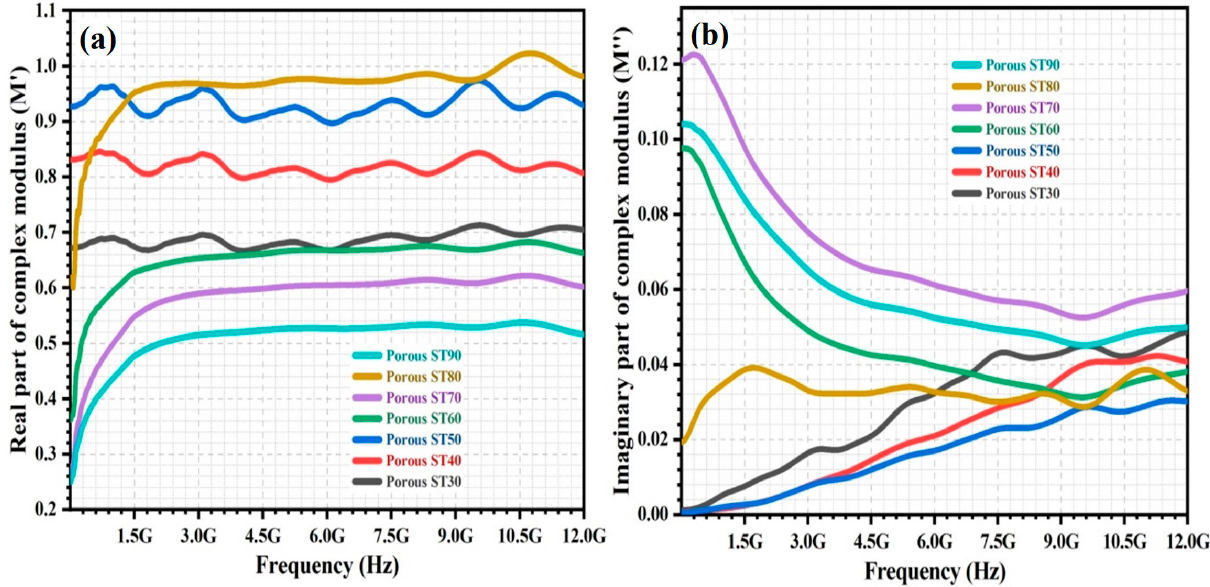
Figure 3. The variation of ( a ) M’ and ( b ) M ″ of porous HAp/ST composites over